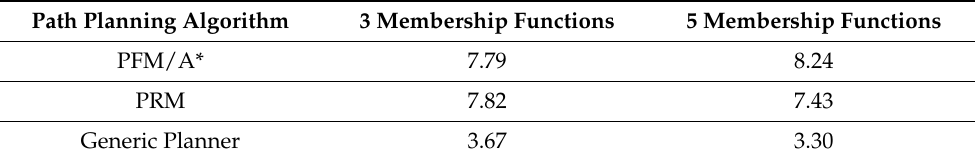
Figure 16. Generic Planner: An example of a poorly traveled path. Table 8. Performance Score Output for Case Study I.